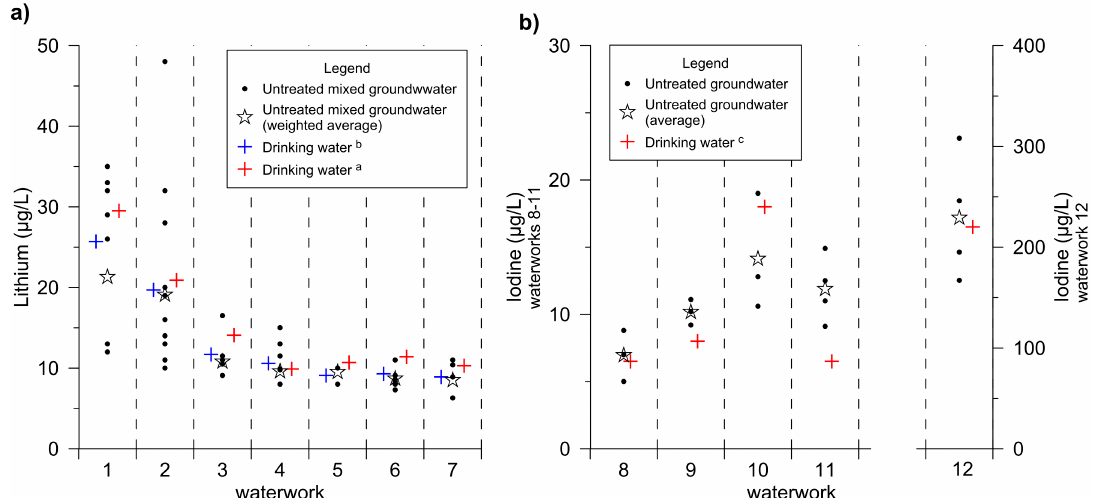
Figure 5. ( a ) Lithium concentrations in untreated mixed groundwater from well sites (black dots) at seven waterworks in the Copenhagen area and in treated drinking water (data from two studies are used: a the ICP-MS data reported here and in [3] (red +), b unreported AAS data provided by the waterworks (blue +; see Supplementary materials for further detail). ( b ) Comparison between I concentrations in drinking water (red +) and untreated groundwater from wells (black dots) of five waterworks located in Jylland ( c data from 2012 reported in